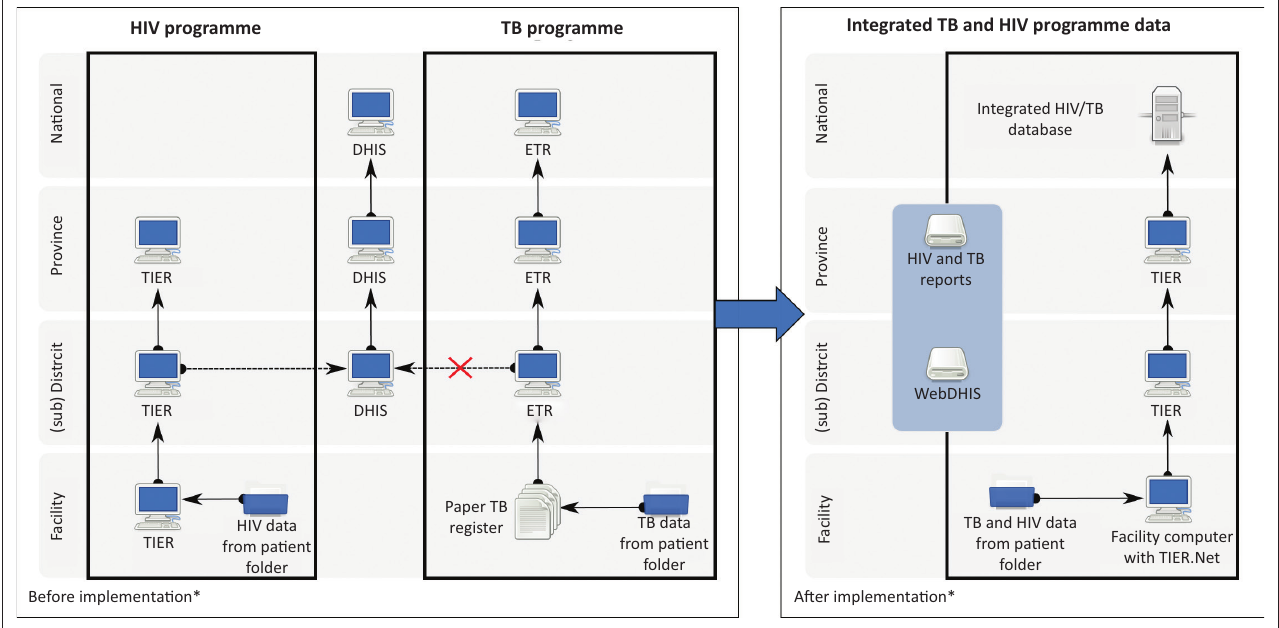
FIGURE 1: The data flow of TB and HIV programme data before and after the implementation of the TB module in TIER.Net. 12 Prior to implementation, the TB and HIV programme comprised two separate systems (TIER, ETR), each maintained on separate hardware with its own support structure; co-infected patients were tracked separately. The TB system emphasises data reporting with the use of paper registers, and facility level staff depend on sub-district TB coordinators for programme feedback; the HIV system (TIER.Net) combines immediate, real-time access to individual and aggregated HIV data for patient management and programme reporting, and is integrated with the DHIS. After implementation, TB and HIV programme data flow up through TIER.Net and are consolidated into one database. TB and HIV programme data are available at all levels of the health system for querying and reporting (national through to facilities) and is integrated with the WebDHIS